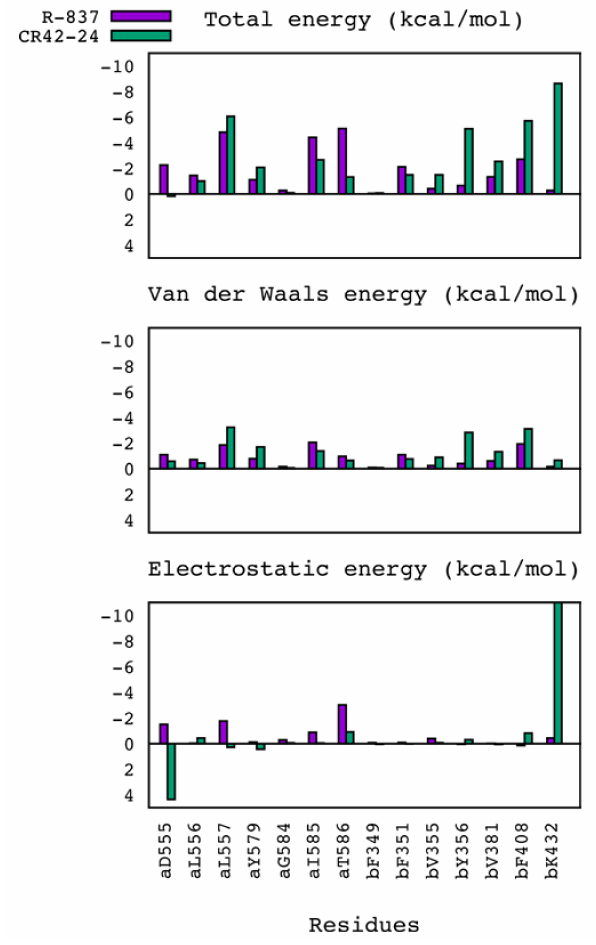
Figure 5. Decomposition of total, van der Waals and electrostatic interaction energies between the residues of the TLR7 pocket and the two compounds R-837 (violet) and CR42-24 (green). Similar patterns were observed for the total and van der Waals interactions of the two compounds with the TLR7 dimer, while the electrostatic interaction pattern was different. The unfavorable interaction of CR42-24 with the key residue aD555 was compensated by a favorable, electrostatic-driven interaction with bK432, which was not observed for other TLR7 ligands in our previous